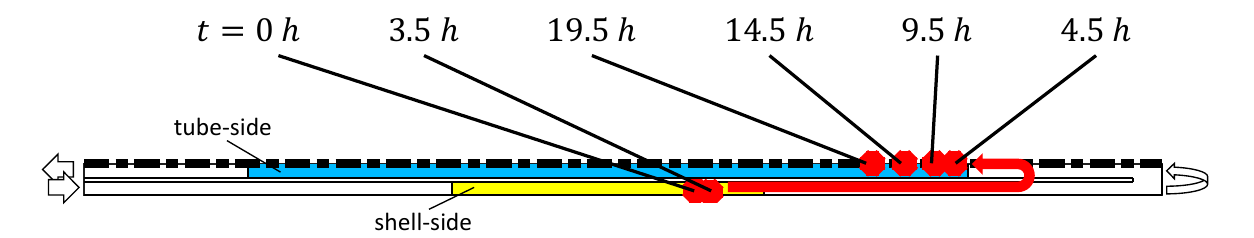
= 1%; x O 3 H 8 , in 2 , in x O = 1%; T W = 3 H 8 ,in 2 ,in